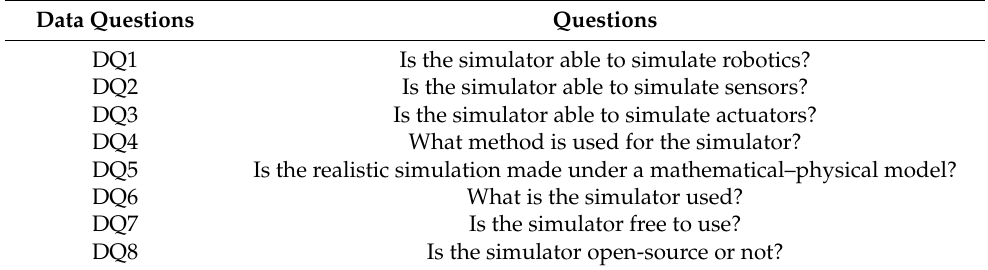
Table 2. Data Extraction